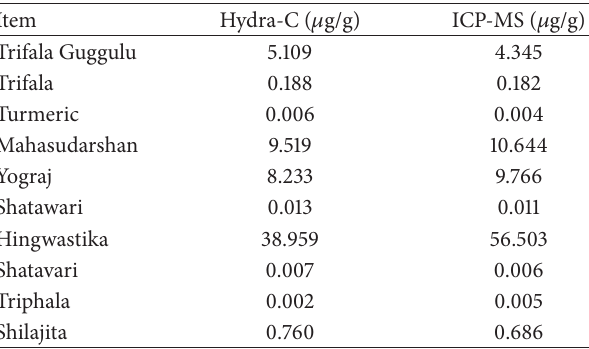
Table 4: Comparison between Hydra C and ICP-MS results, measured in duplicate.